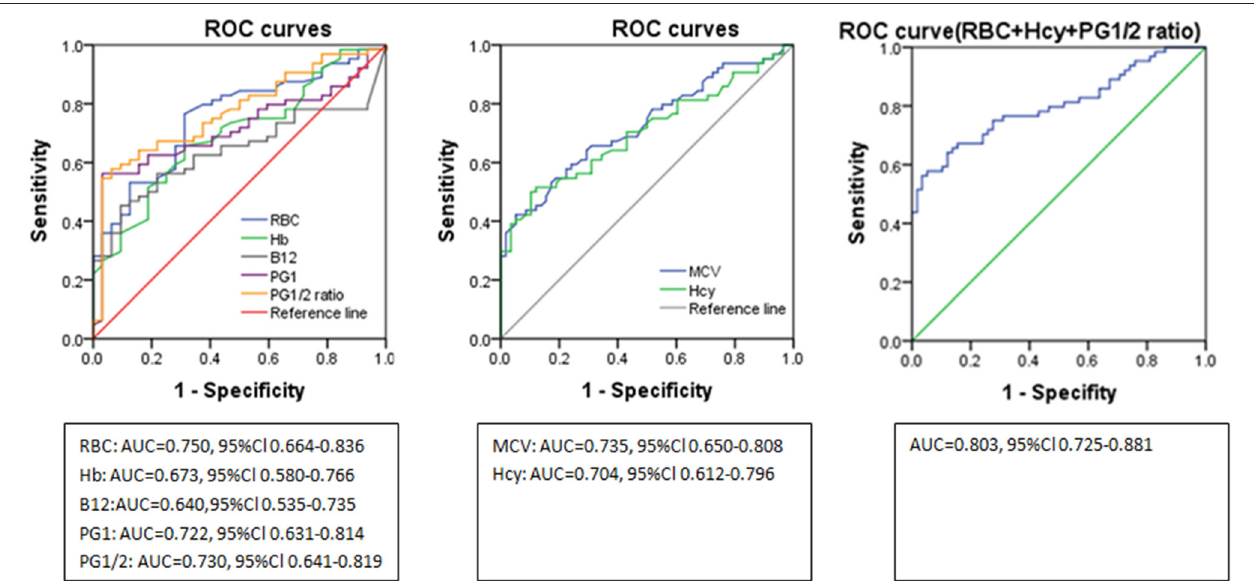
FIGURE 3 | ROC curves of the laboratory parameter in distinguishing subacute combined disorder from amyotrophic lateral sclerosis. ROC, receiver operating characteristic; RBC, red blood cell; Hb, hemoglobin; PG1/2, pepsinogen 1/pepsinogen 2; MCV, mean corpuscular volume; Hcy, homocysteine; AUC, area under the curve.